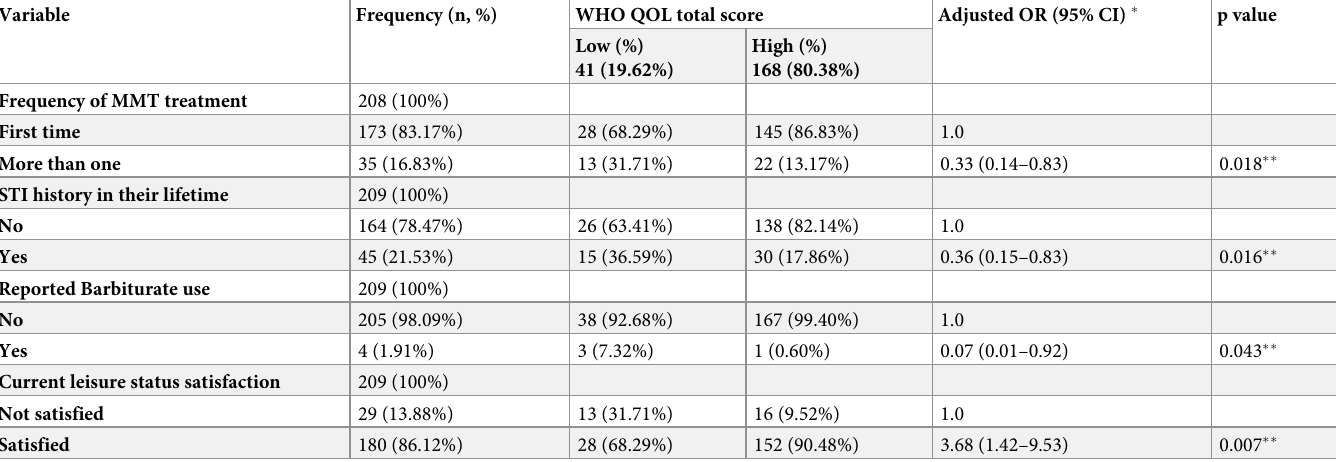
Table 3. Table showing the association between the QOL total score and significant characteristics among methadone